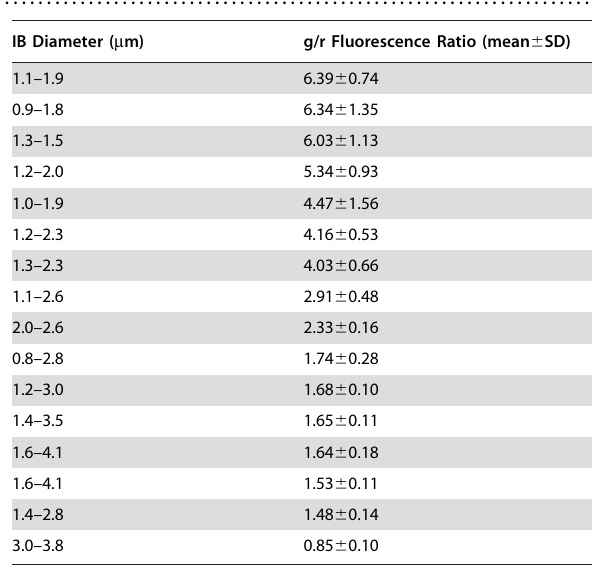
Table 2. Non-linear relationship between g/r ratio and IB